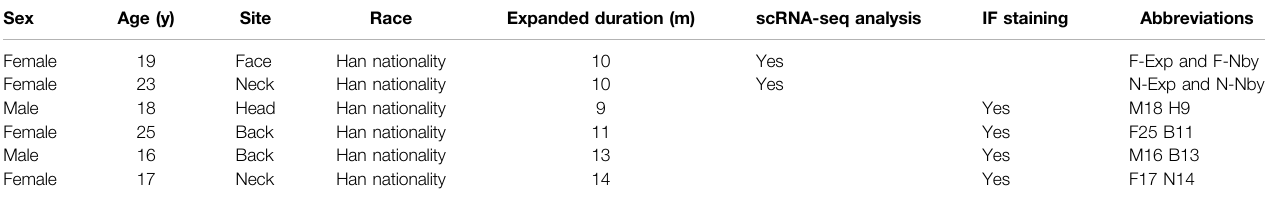
TABLE 1 | Clinical information of patients whose samples were used in this